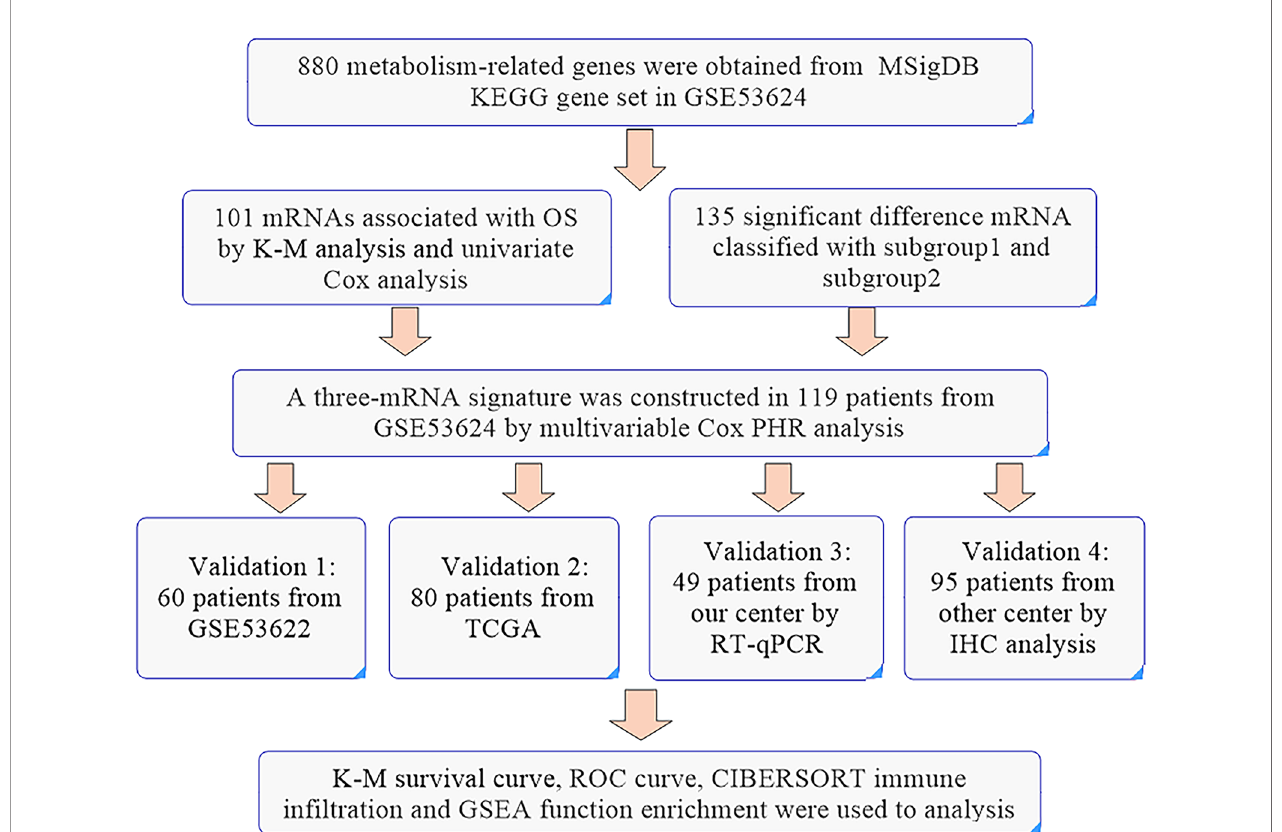
FIGURE 7 | The work fl ow of the identi fi cation of a three-gene metabolism-related